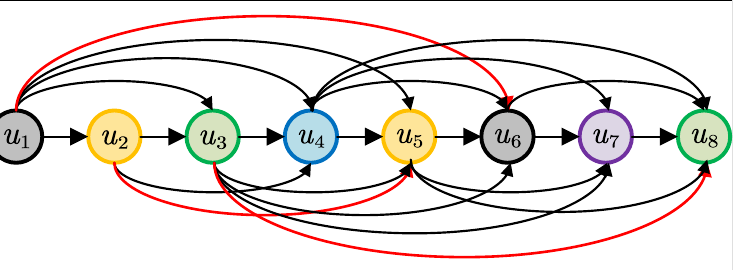
Figure 3. The sample of CSG. The utterances of the five speakers are represented by different colors. The red lines denote the edge e 0 , and black lines represents the edge e 1